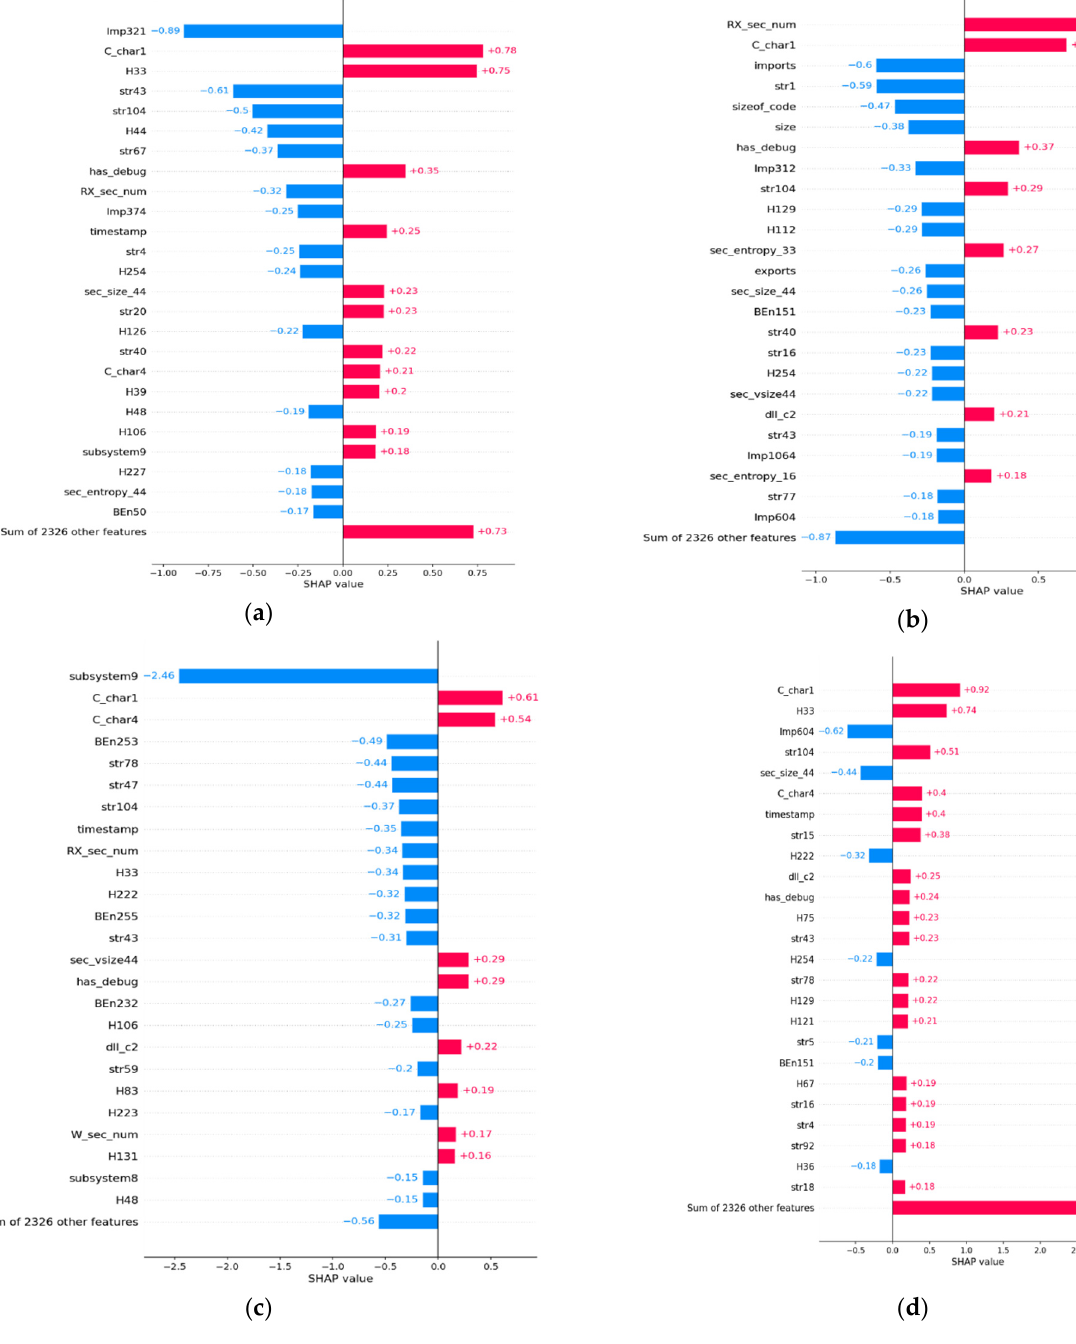
Figure 4. Bar plot of a FP sample ( a ), a FN sample ( b ), a TP sample ( c ), and a TN sample ( d ) from the D2 dataset in shap value.